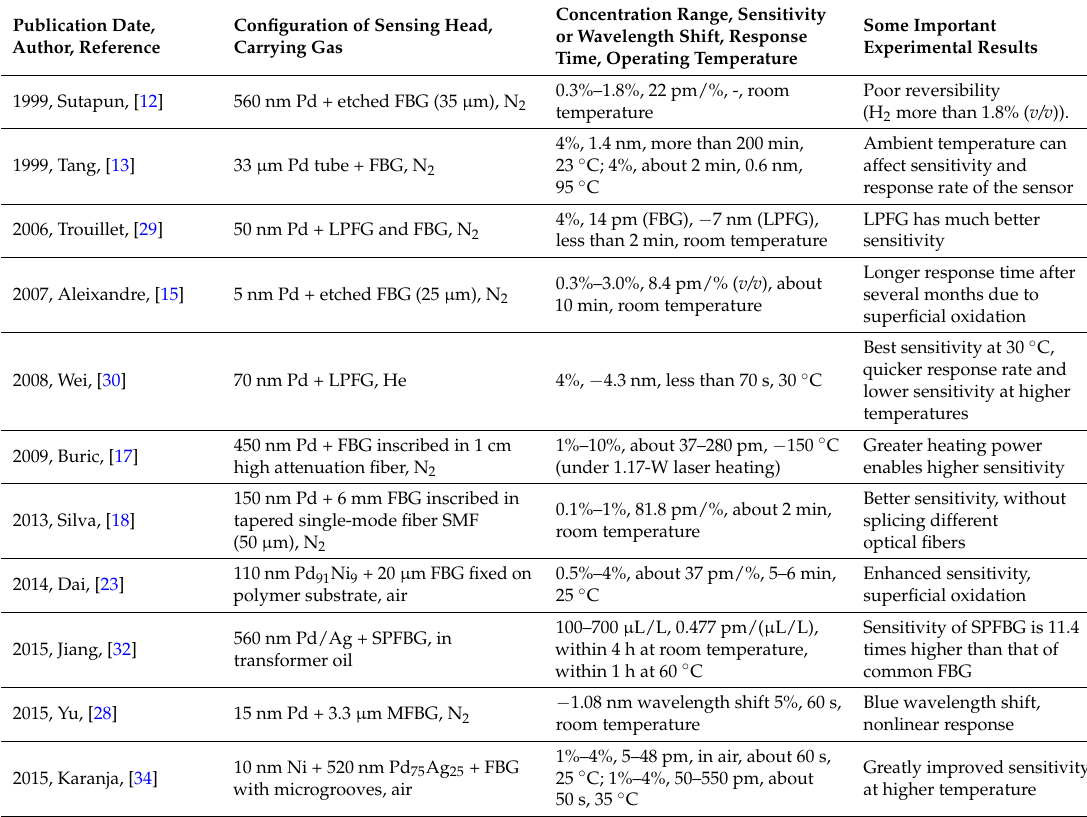
Table 1. Comparison of fiber grating hydrogen sensors based on Pd and Pd